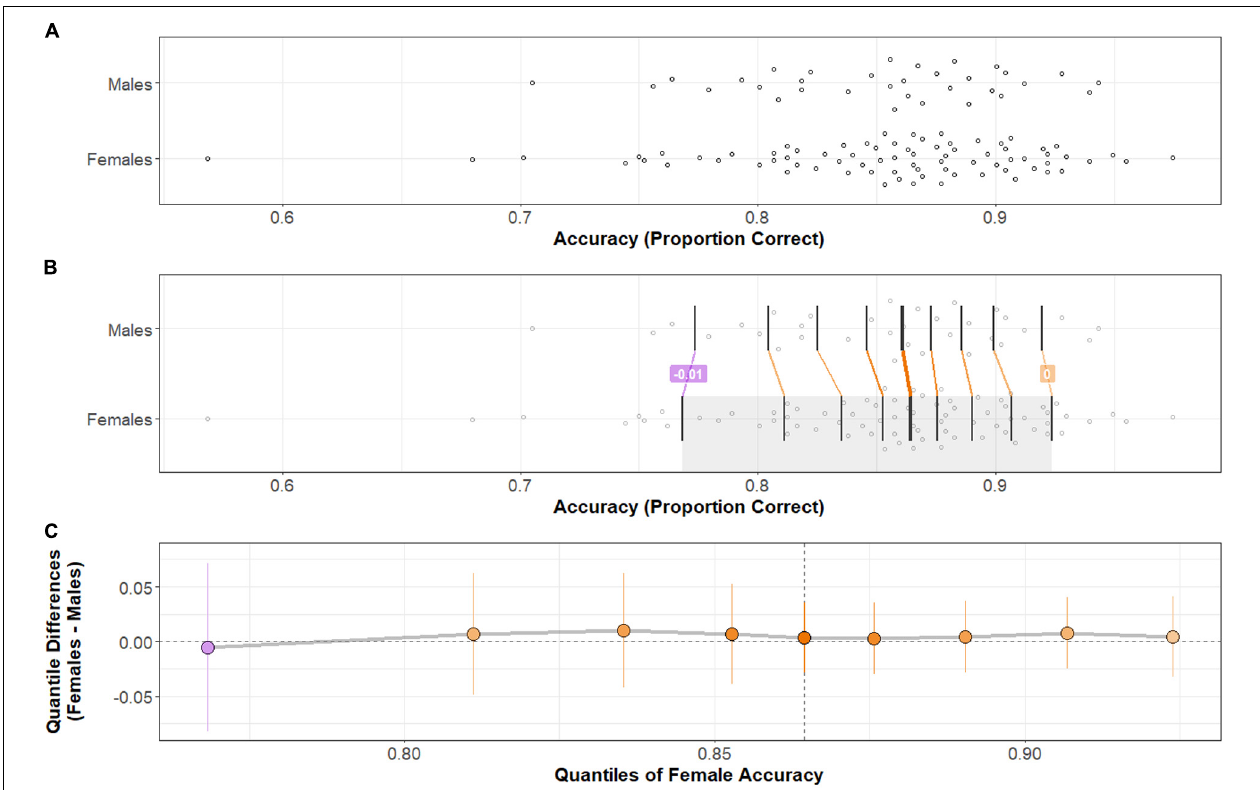
FIGURE 2 | Accuracy distributions by group and comparison by shift function. (A) Stripchart of Accuracy distributions by group. (B) Stripchart shown in (A) with quantiles (vertical black bars) and differences between distribution quantiles characterized. When the difference between quantiles (Females–Males) is negative, the connecting line between corresponding quantiles is purple; when positive, orange. The heavier weight vertical black bar denotes the median (5th quantile) of each distribution. (C) Shift function between Male and Female distributions. Range of the x -axis corresponds to the shaded region of the Female distribution in (B) . Y -axis shows the difference between group distributions by quantile: as in (B) , purple indicates a negative difference; orange indicates a positive difference. Points indicate how much the Male distribution would need to shift at a particular quantile to match the corresponding quantile in the Female distribution. Vertical lines at each point represent a bootstrapped 95% confidence interval about the difference. Note that difference points all near zero and confidence intervals at every quantile difference point cross over zero: there is no significant difference in Accuracy across Task-types between Females and Males. Two-sample, two-sided Kolmogorov–Smirnov test: D = 0.09, p >